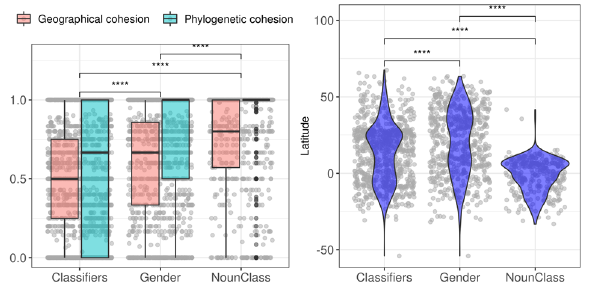
Fig. 2 The distribution of different measures of classi fi er, gender, and noun class systems. a Shows the distribution and average of geographic and phylogenetic cohesion of classi fi ers, gender, and noun class. Gender and noun class are stronger than classi fi ers in terms of geographic cohesion and in particular in phylogenetic cohesion. b Shows the distribution of classi fi ers, gender, and noun class with respect to latitude. Classi fi ers and gender are more evenly distributed than noun class, which is concentrated in the southern hemisphere.